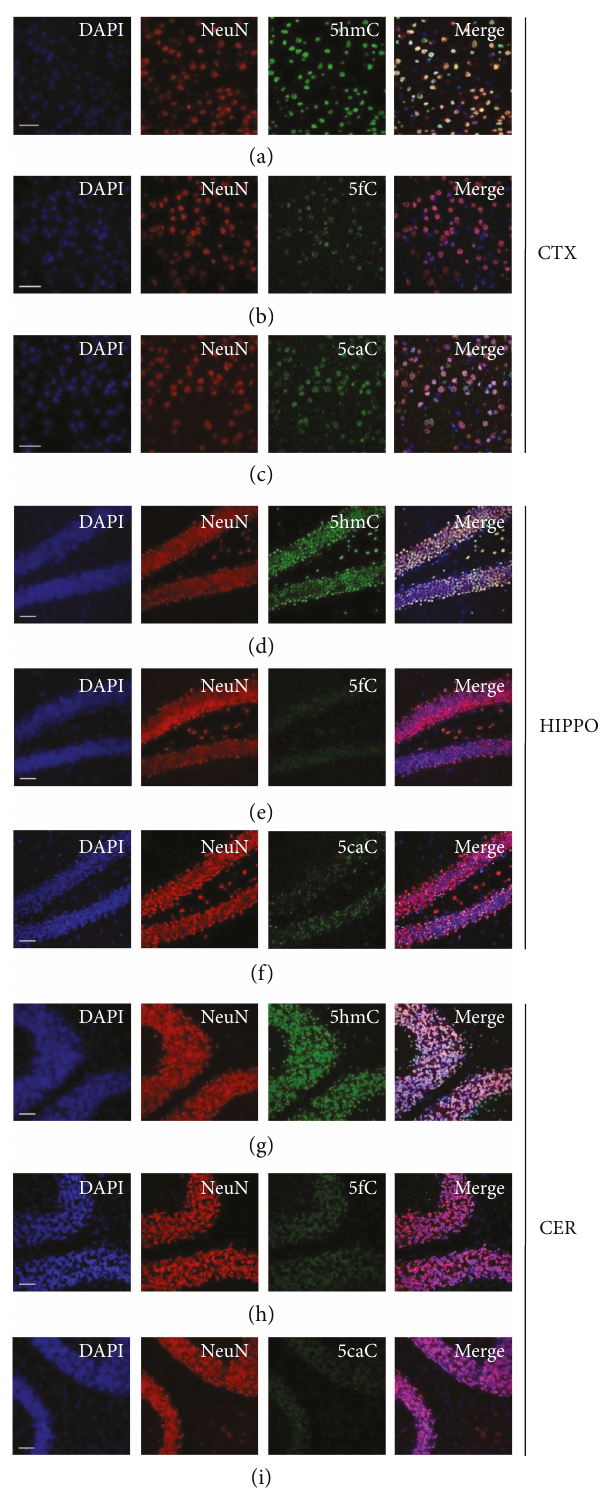
Figure 1: The representative immuno fl uorescence images of 5hmC, 5fC, and 5caC in the cortex, hippocampus, and cerebellum. Immuno fl uorescence of 5hmC (a), 5fC (b), and 5caC (c) in the 8 w cortex. Immuno fl uorescence of 5hmC (d), 5fC (e), and 5caC (f) in the 8w hippocampus. Immuno fl uorescence of 5hmC (g), 5fC (h), and 5caC (i) in the 8 w cerebellum. Scale bar, 200 μ